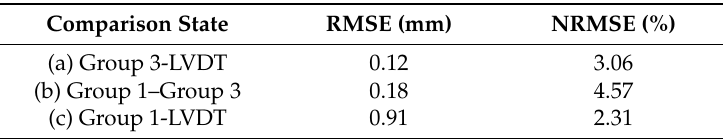
Table 2. Deformation measurement